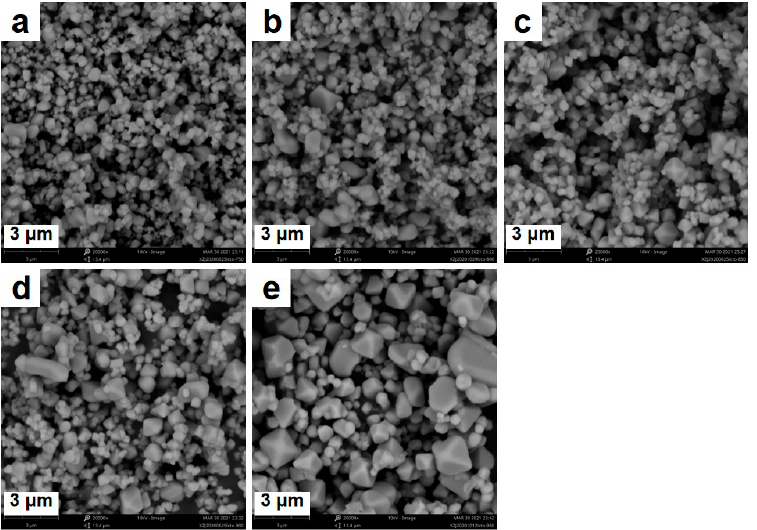
Figure 1. The SEM (Scanning electron microscope) images of LiCrTiO 4 sintered in a powder form at a temperature of ( a ) 750 °C; ( b ) 800 °C; ( c ) 850 °C; ( d ) 900 °C and ( e ) 950 °C.